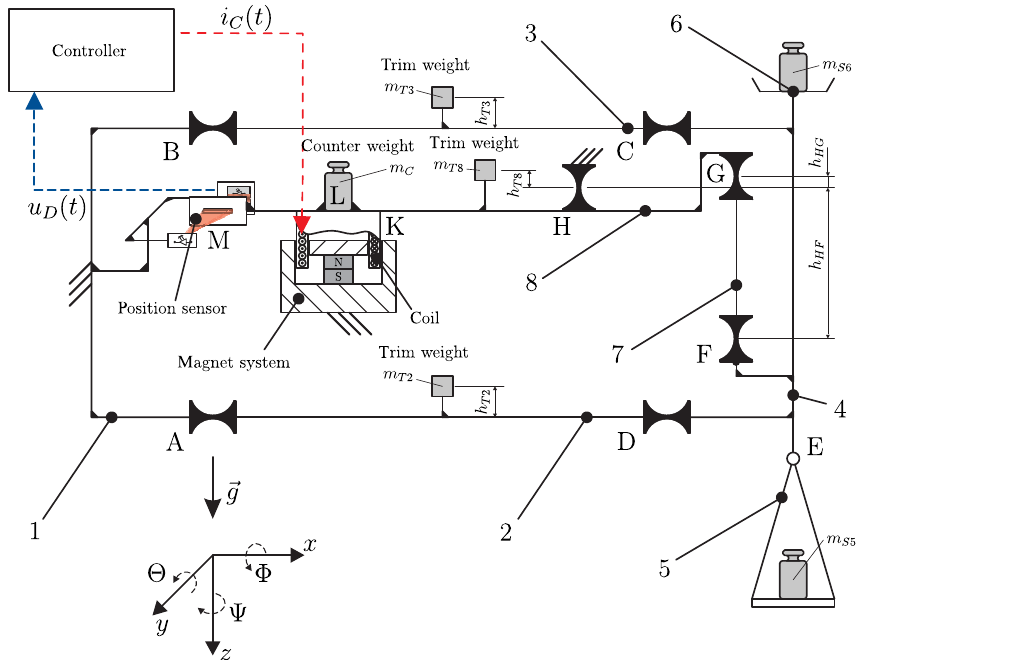
Figure 1. Monolithic EMFC weighing cell with flexure hinges and typical joint orientation. 1 – base, 2 – lower lever, 3 – upper lever, 4 – load carrier, 5 – lower weighing pan, 6 – upper weighing pan, 7 – coupling element, 8 – transmission lever.